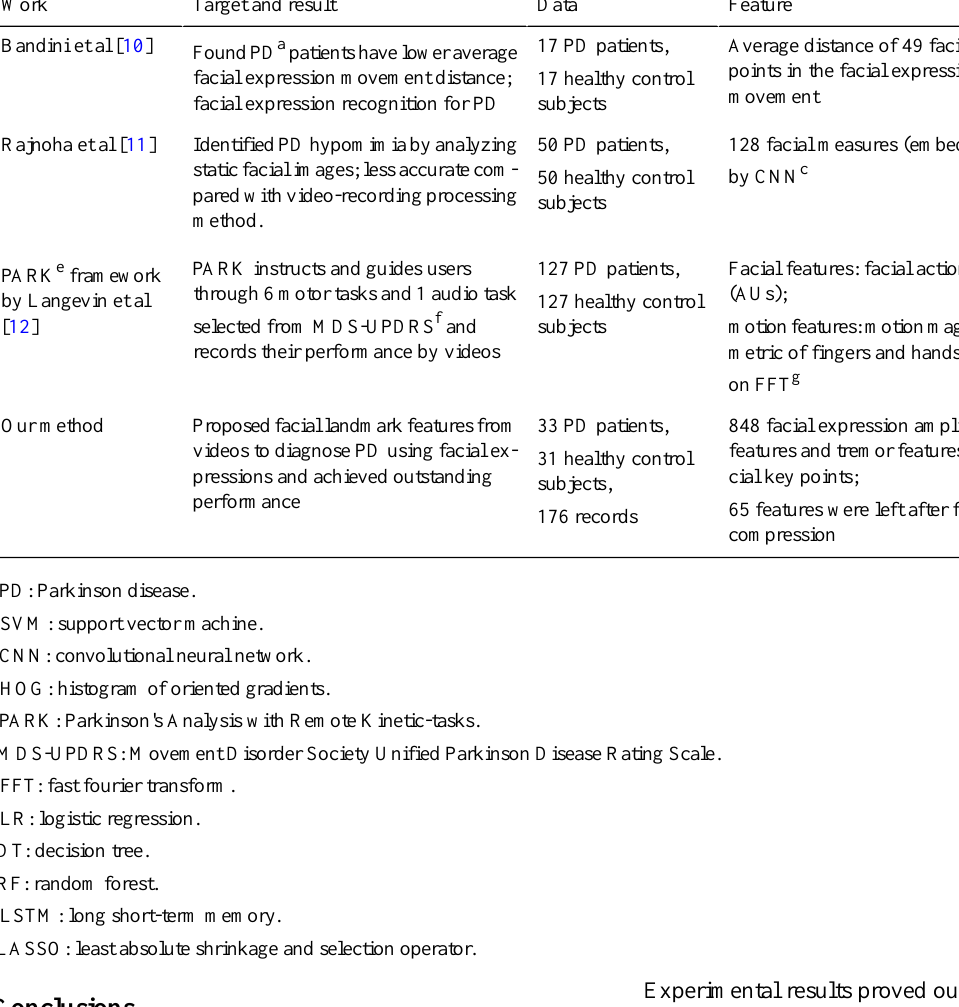
Table 6. Comparison with a selection of prior work. TechnologyFeatureDataTarget and